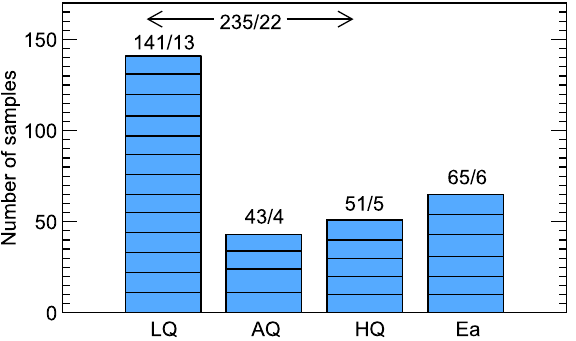
Figure 2. Number of examined samples/number of bottles for various studied wines categories. LQ—low quality, AQ—average quality, HQ—high quality, and Ea—diluted ethanol. Number of samples from each bottle is represented by bar